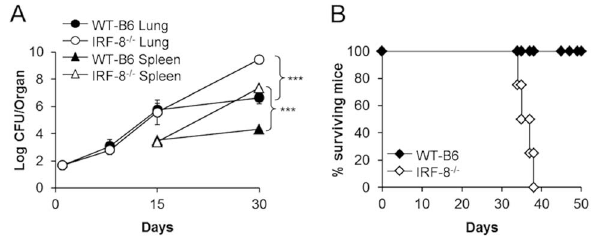
Figure 1. Increased susceptibility of IRF-8 2 / 2 mice to Mtb infection. IRF-8 2 / 2 and WT-B6 mice were infected with 100 CFU Mt b via the aerosol route. A) Bacterial loads, determined as CFU, in spleens and lungs at days 8, 15 and 30 p.i. Data are expressed as mean 6 SEM of each individual mouse (n=5 mice/group). *** P , 0.001 IRF-8 2 / 2 vs. WT-B6 at day 30 p.i. B) Surviving mice (n=5 mice/group). One representative experiment out of three is shown.